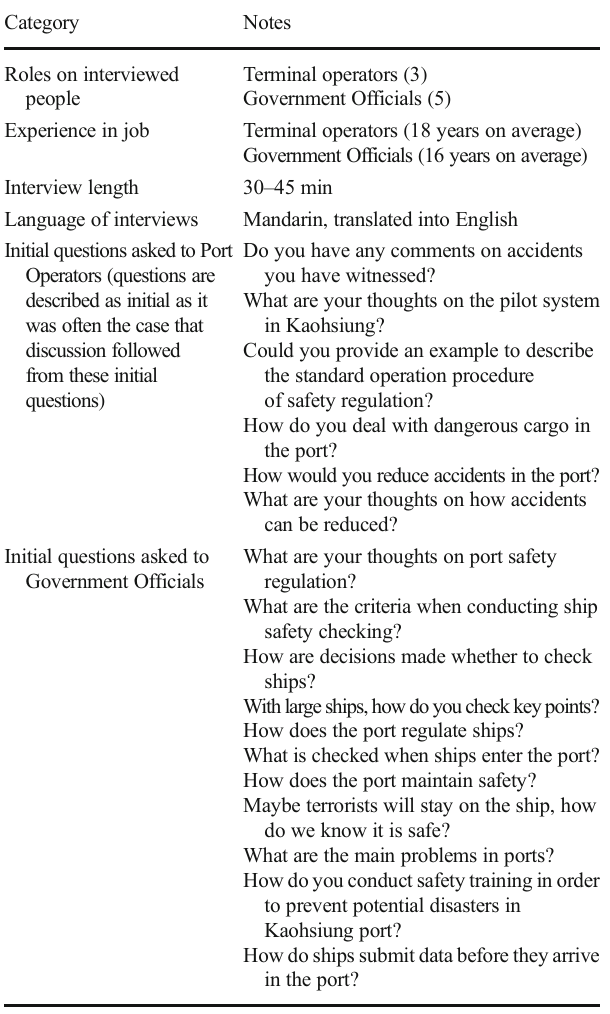
Further details on the interviews and the questions